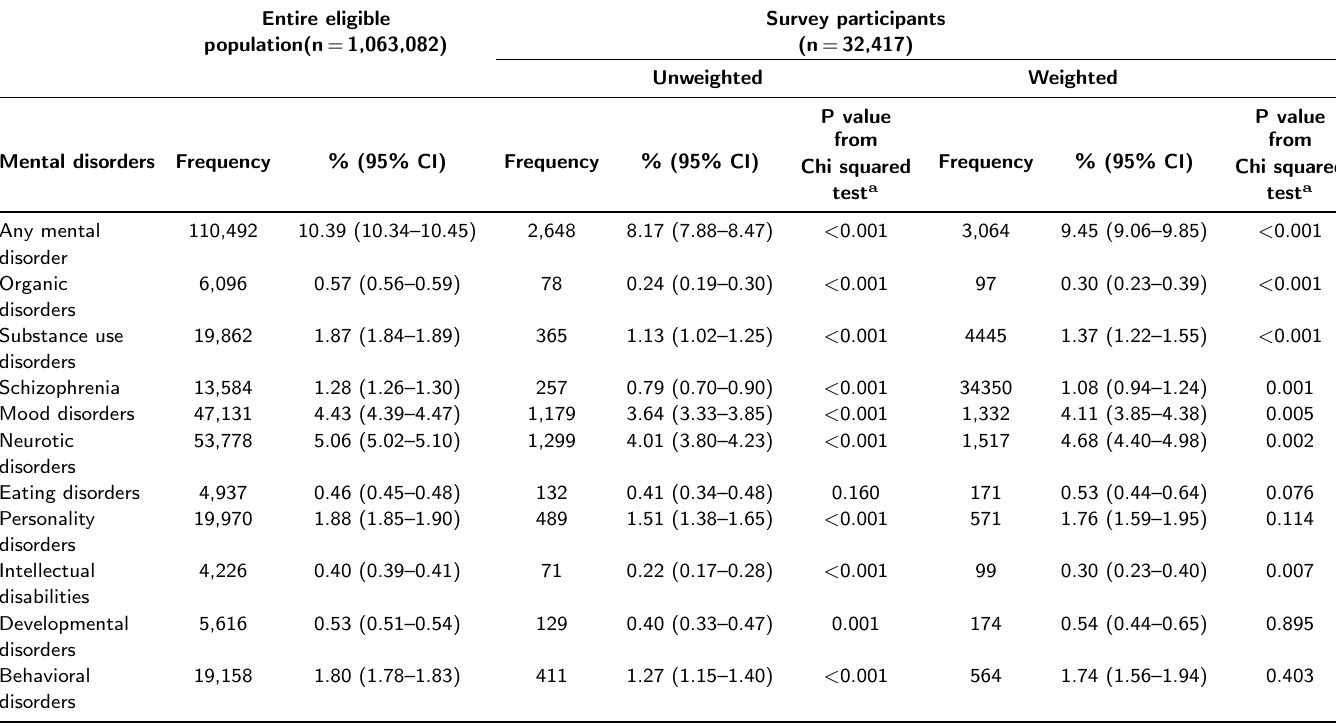
a Comparing the frequencies observed in the unweighted and weighted survey participants, with the frequencies expected if the proportions had been the same as in the entire eligible population.